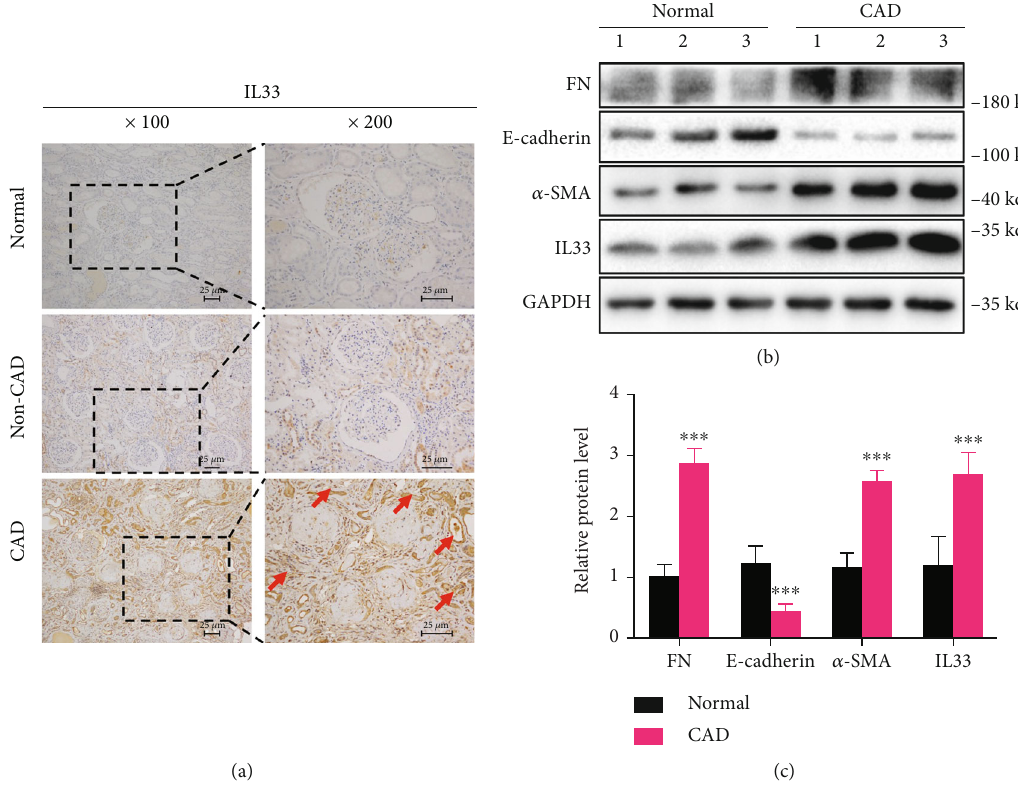
Figure 3: Validation of association between target SNP gene (IL-33) and renal graft fi brosis. (a) IHC staining using anti-IL-33 antibodies demonstrated more deposition of IL-33 in renal tubules (red arrow) was found in graft fi brosis tissues of CAD than normal tissues. Scale bar: 25 μ m. (b) Representative WB results showed IL-33 expression as well as EMT-related markers including FN and α -SMA in the CAD group exceeded those in the normal group, while E-cadherin expression was higher in the normal group than the CAD group. (c) Semiquantitative analysis results of relative protein abundances of FN, E-cadherin, α -SMA, and IL-33 were shown in each group. Values represented the mean ± SD ( n = 3 ; ∗∗∗ P < 0 : 001 ). Abbreviations: SNP: single nucleotide polymorphism; IHC: immunohistochemistry; CAD: chronic renal graft dysfunction; WB: western blot; EMT: epithelial-mesenchymal